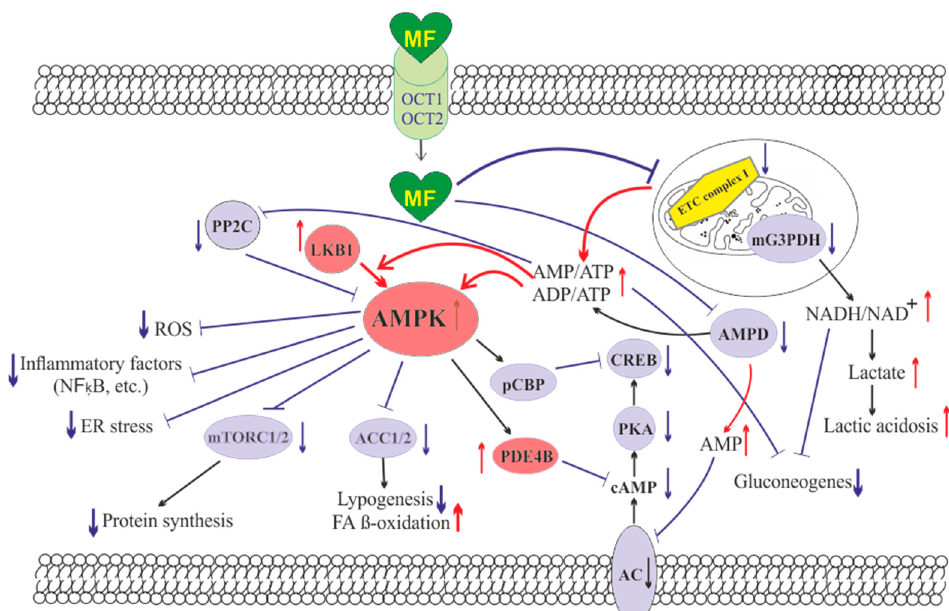
Figure 1. The cellular mechanisms of metformin action which are carried out by activation of the AMP ‐ activated protein kinase and inhibition of the mitochondrial electron transport chain com ‐ plex I. Abbreviations: AC, adenylyl cyclase; ACC1/2, acetyl ‐ CoA carboxylases 1 and 2;